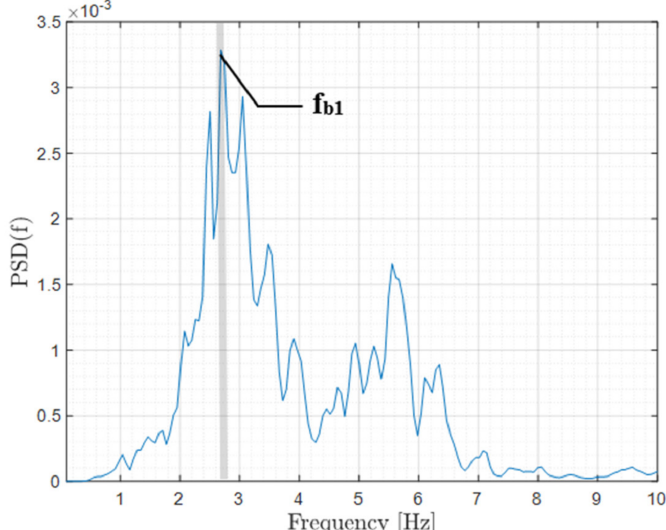
Figure 10. Auto PSD related to the identification of the bridge frequency from the